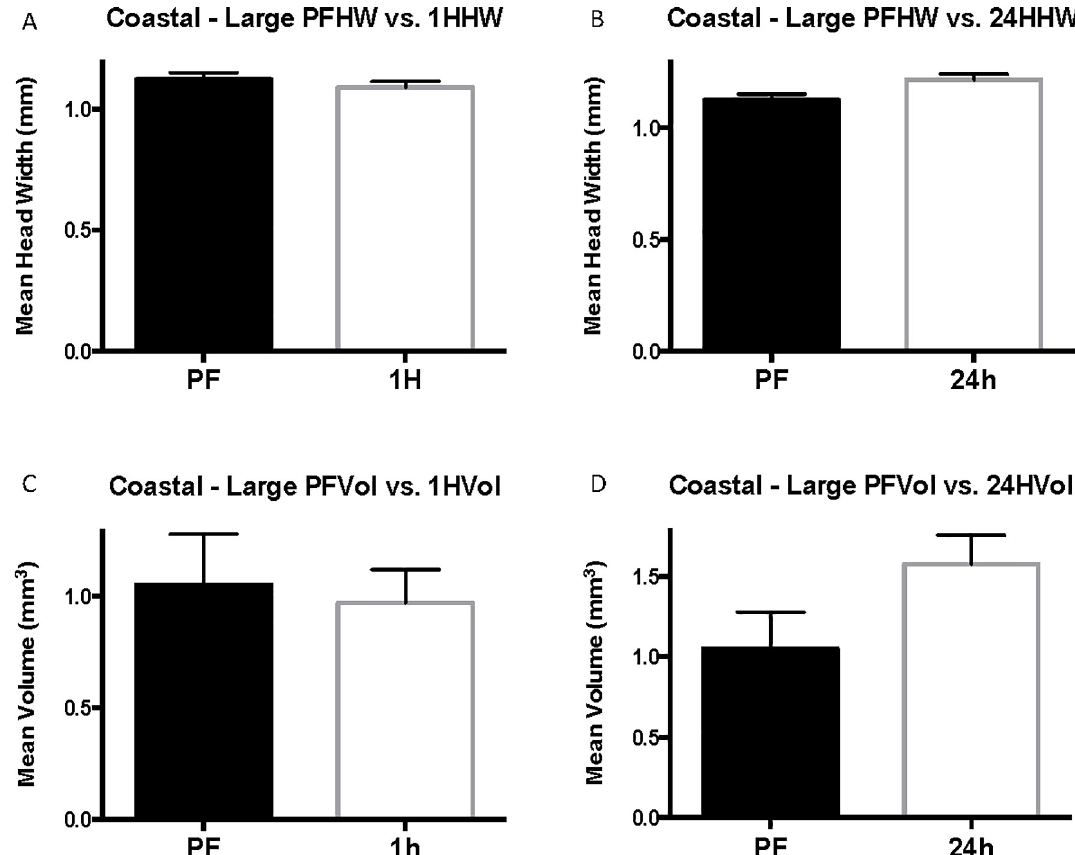
Fig 5. Large coastal head width (HW) and venom sac volume (Vol). Mean head width is in mm. Mean venom sac volume is in mm 3 . The error bars represent standard error of the mean. PF refers to the pre-flood cohort (n = 5), 1H refers to the 1-hour cohort (n = 7), and 24h refers to the 24-hour cohort (n =